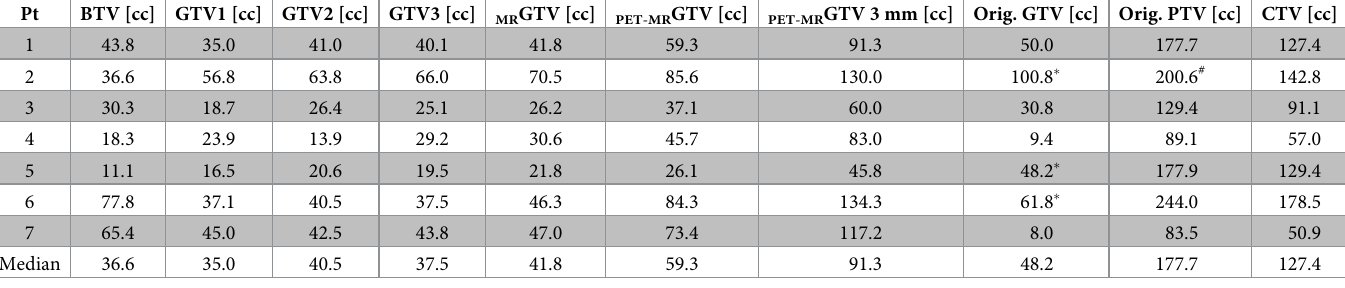
Table 2. Tumour volumes and planning target volumes. Biological tumour volume (BTV), gross tumour volume (GTV) of three radiation oncologists and consensus structure ( MR GTV), union of biological tumour volume with consensus gross tumour volume ( PET-MR GTV) and corresponding volume with 3 mm margin, original GTV, original planning target volume (PTV) and an extracted clinical target volume